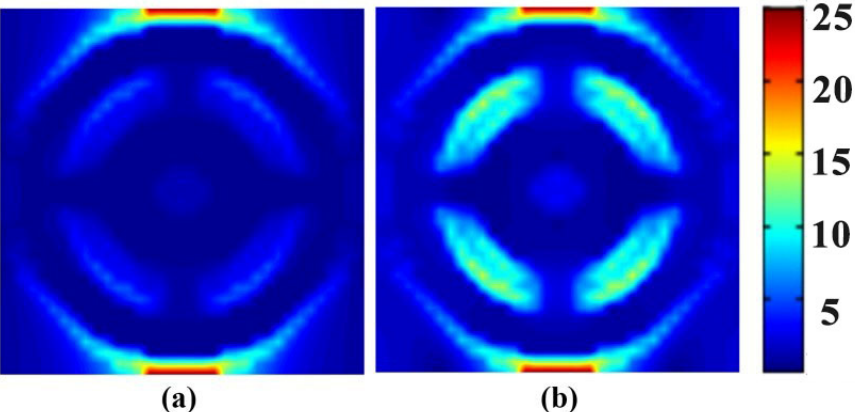
Figure 3. The cross-sectional electric field distribution on the absorber surface in the x-y direction when the incident light frequency is ( a ) 5.664 THz and ( b ) 8.062 THz, respectively.